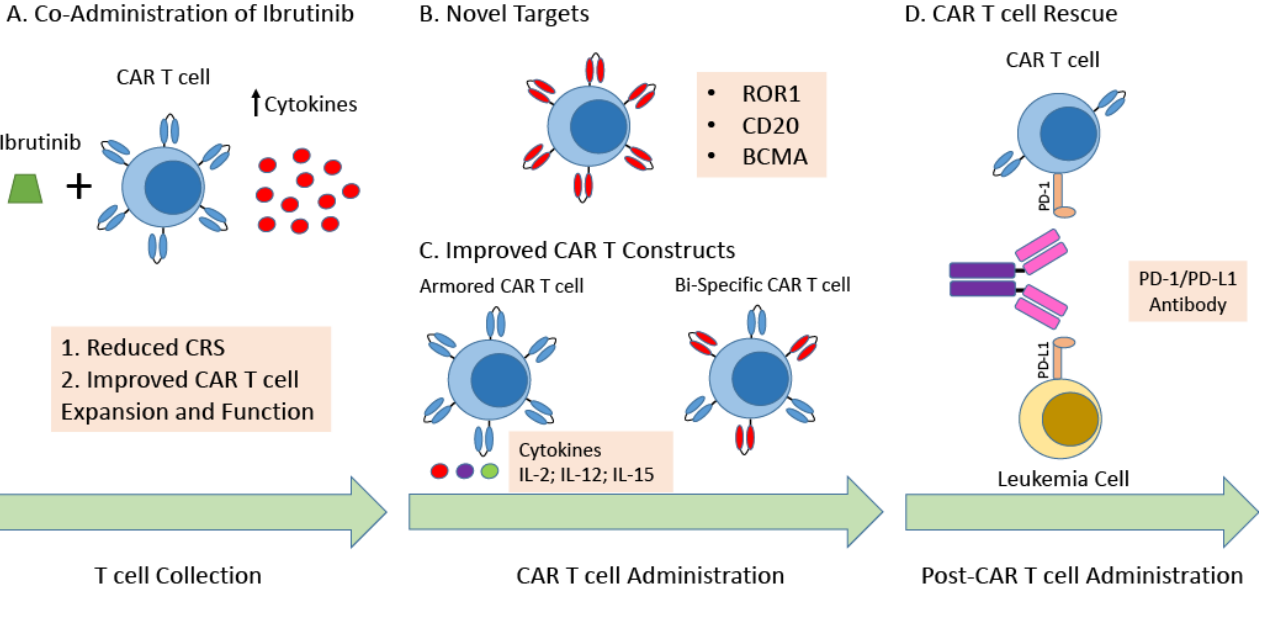
Figure 2. Strategies to Improve CAR T cell Therapy for Patients with CLL. ( A ) Co-administration of ibrutinib. The administration of ibrutinib prior and concomitantly with CAR T cell therapy has demonstrated improved safety with a reduction in cytokine release syndrome, and at least in preclinical models has demonstrated improved functionality of autologous CAR T cells. ( B ) Novel Targets. Targeting novel targets/antigens such as ROR1, CD20, or BCMA may be able to lead